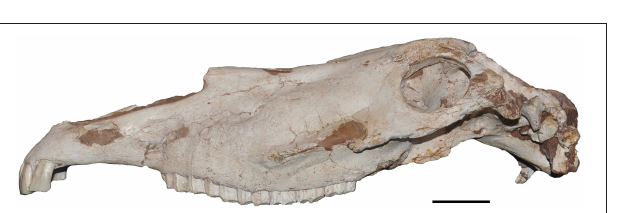
FIGURE 8 | Left lateral view of skull of E. teilhardi , PMU M 1321, collected from Qixian, Shanxi, housed in Museum of Evolution, Uppsala University. Scale bar =